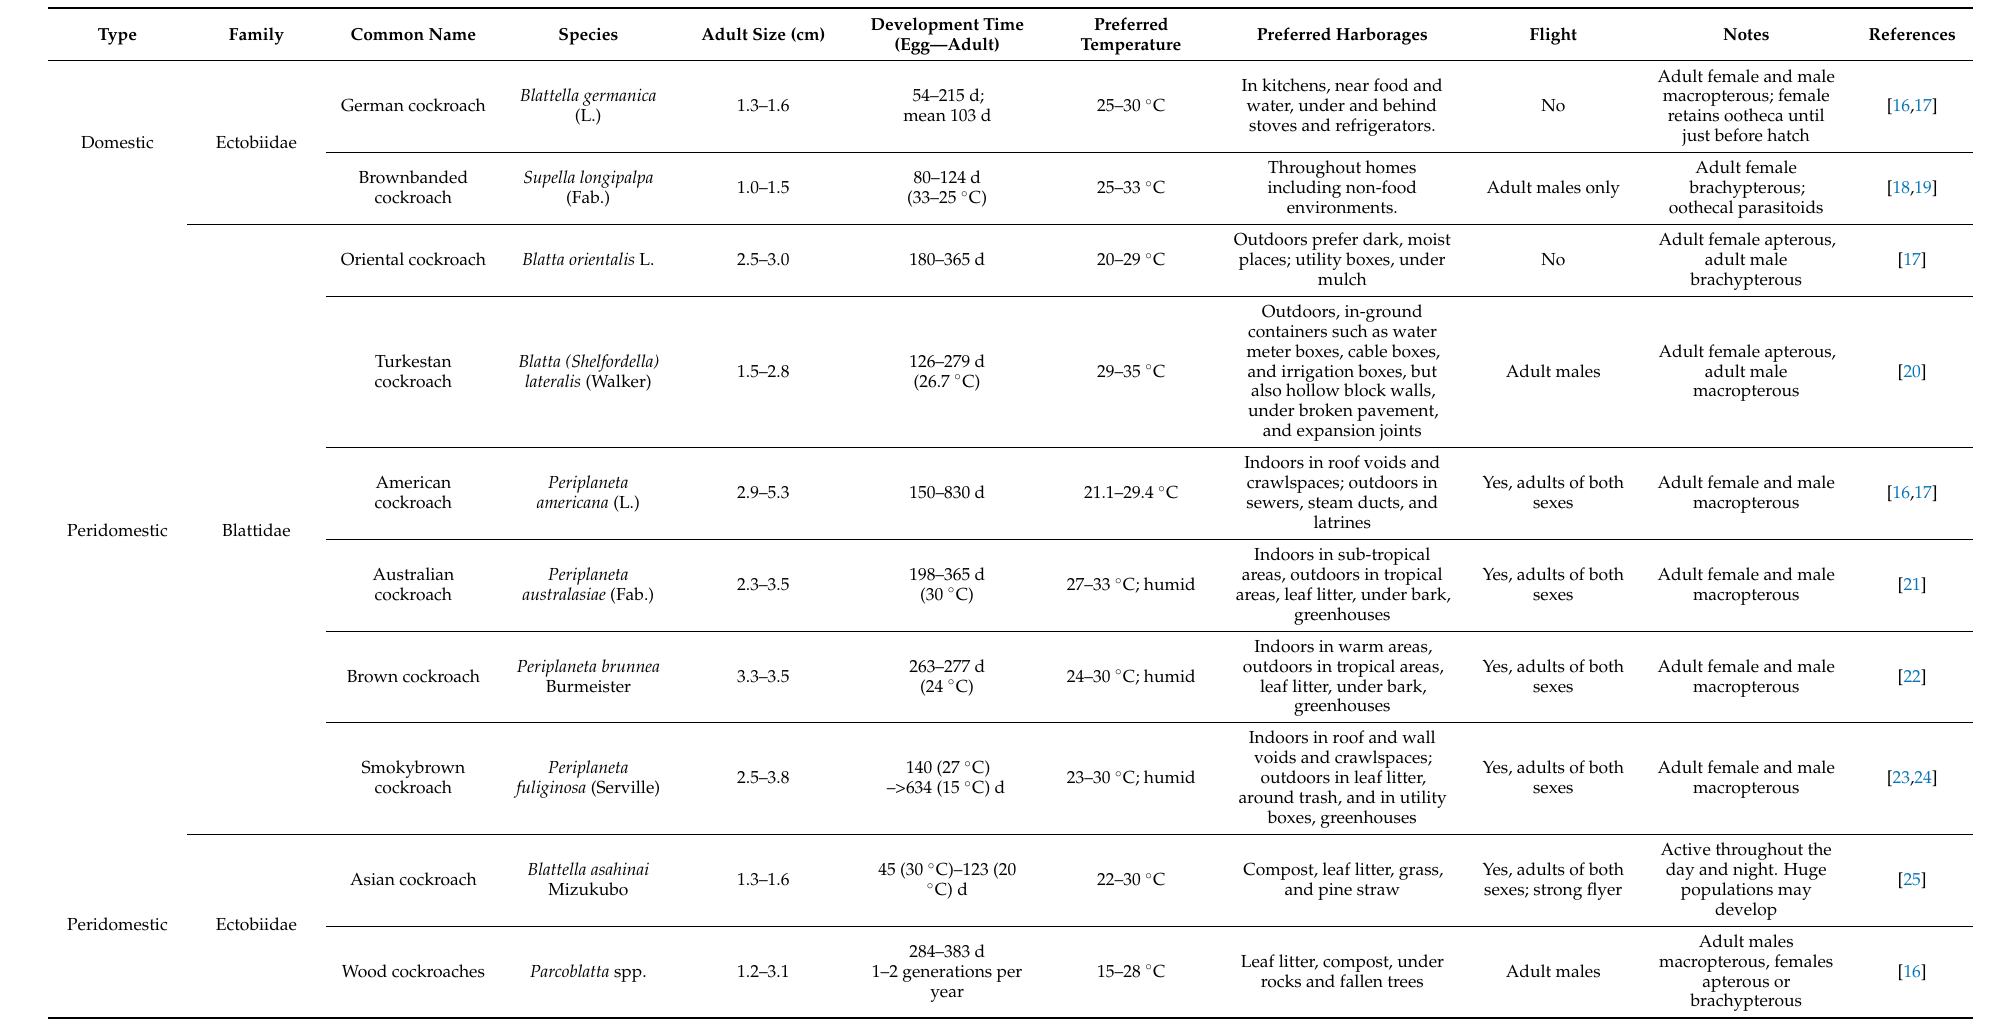
Table 1. Primary domestic and peridomestic cockroach pest species in the United